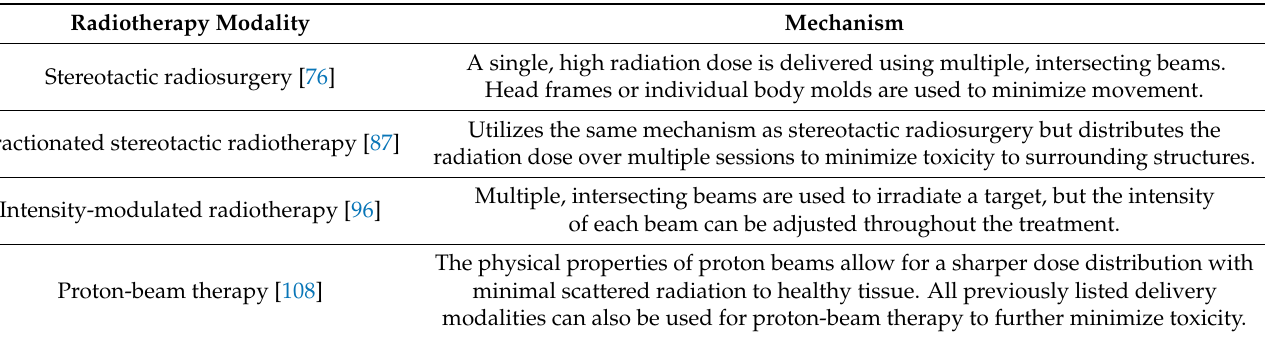
Table 3. Radiotherapy modalities and mechanism of